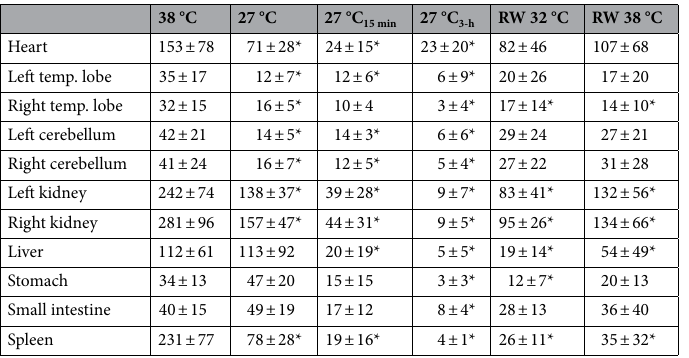
Table 2. Organ blood flow (ml/min/100 g). n = 8, values are mean and SD. * p < 0.05 statistically significantly different from baseline